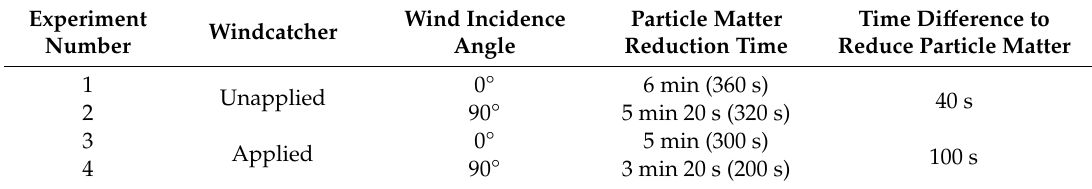
Table 8. E ff ects of the incidence angle of the wind for di ff erent louver configurations.